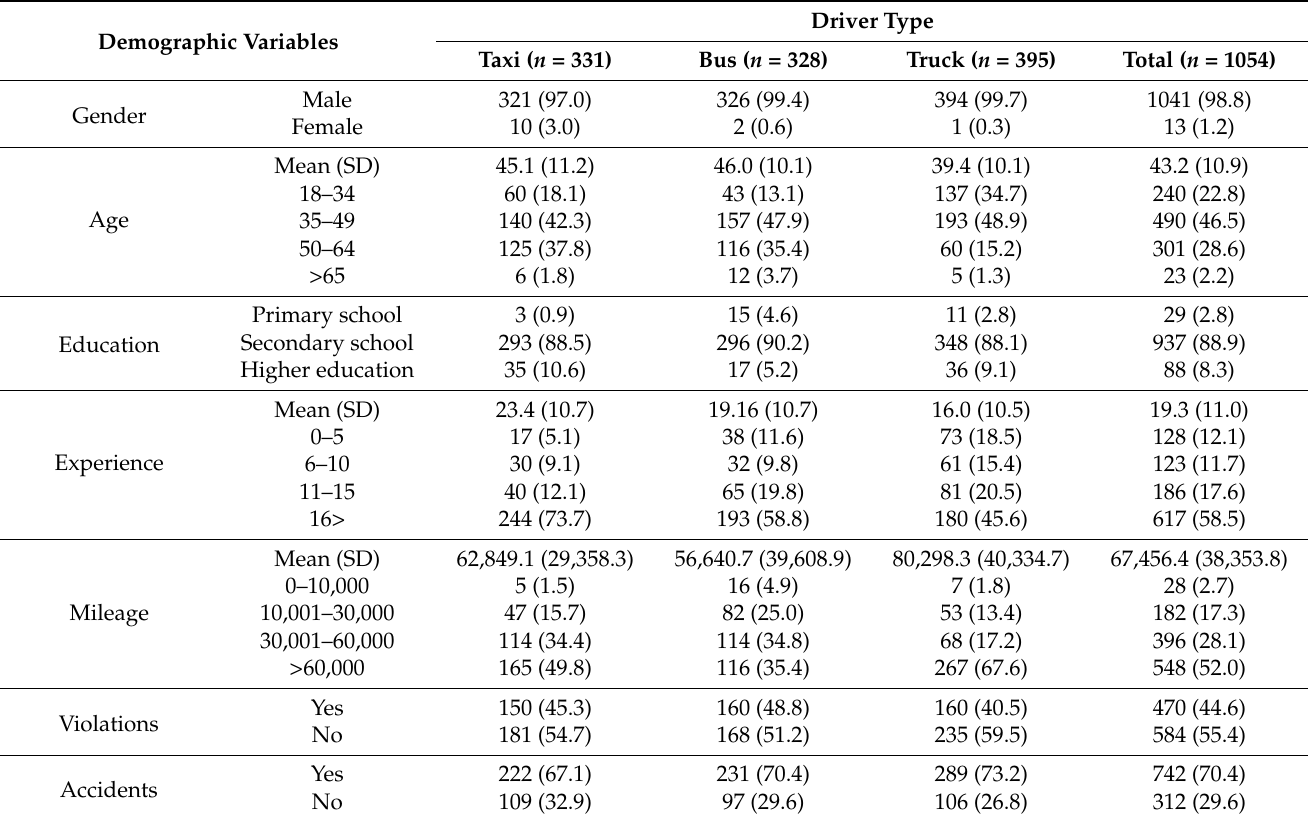
Table 1. Demographic and driving characteristics of professional drivers by categories of driving licences in all the